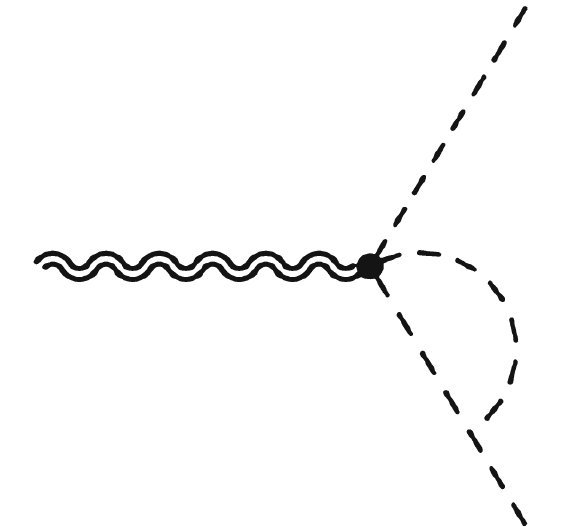
Fig. 3 Diagram for the third one-loop amplitude